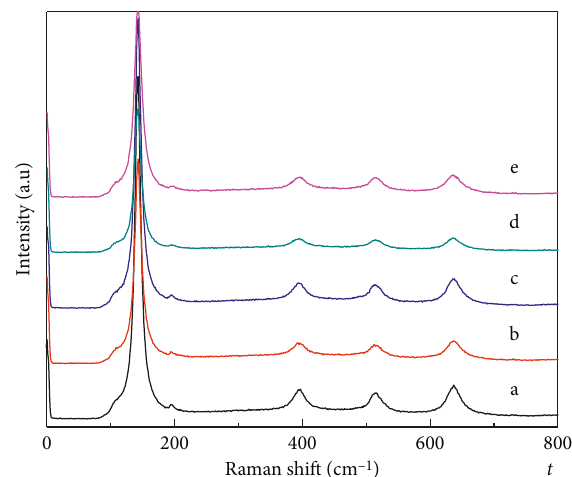
Figure 1: Photocatalytic reaction device for antibacterial